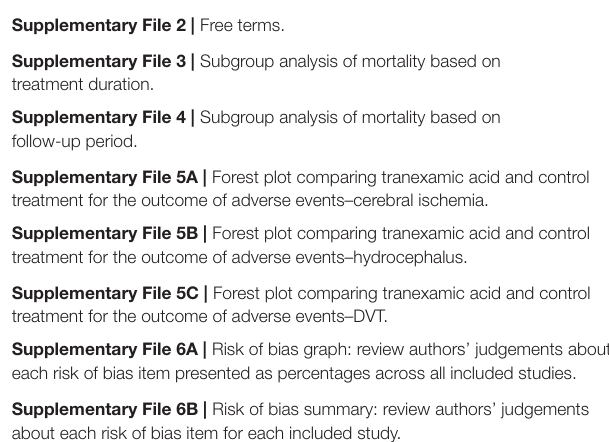
Supplementary File 3 | Subgroup analysis of mortality based on treatment duration. Supplementary File 4 | Subgroup analysis of mortality based on follow-up